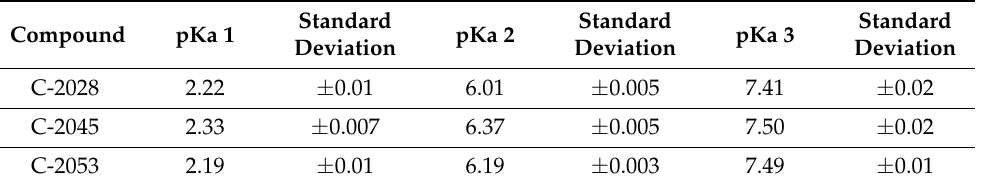
Figure 1. The titration curves obtained by the principal component analysis for the studied compounds as the relations between mole fractions of each spectral form in UV-vis spectra and pH values of the compound solutions. Individual spectral forms: xA, xB, xC and xD correspond to different degrees of bisacridine protonation, H 3 UA +3 , H 2 UA +2 , HUA + and UA. The pH values equal to 0.5 mole fraction for adjacent forms respond to pKa values specific for each acid-base equilibrium. Table 2. PKa values determined for the studied UAs. The standard deviations of the results were determined by cross-validation